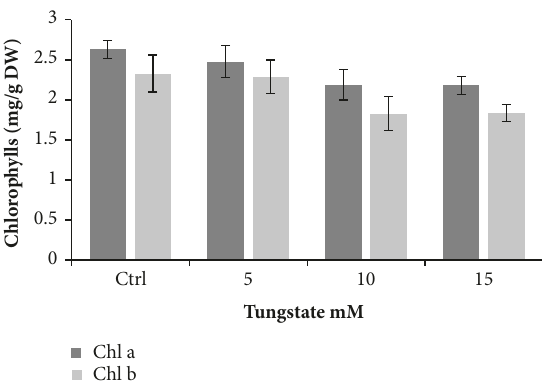
Figure 4: Effect of tungstate dose on chlorophyll a and b of D. tertiolecta at 15 days of culture on F/2. Tungstate was added at 7th day of culture. Data are mean ± standard